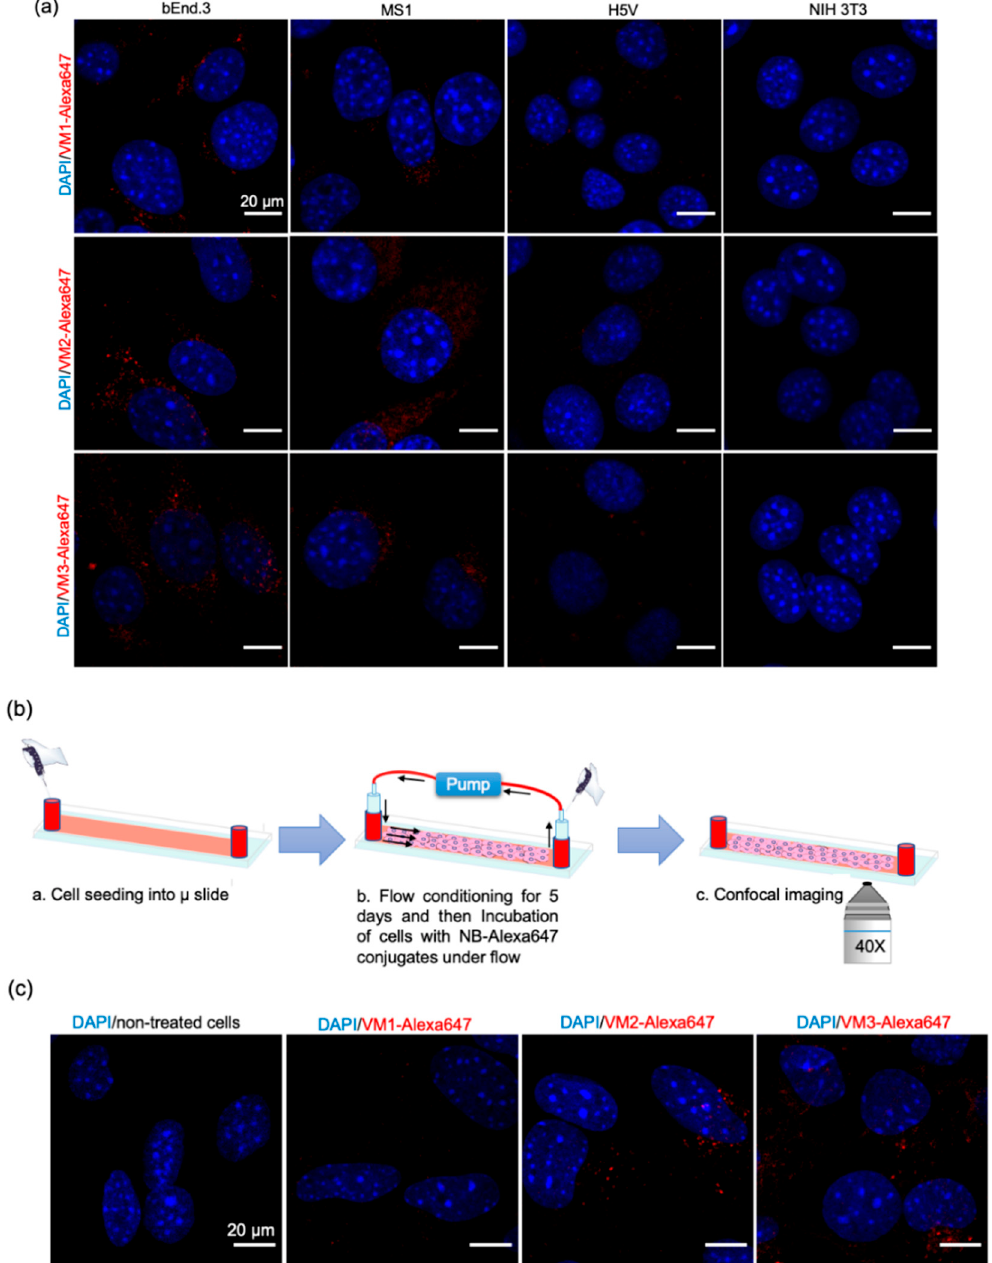
Figure 2. Association of the NB–Alexa647 conjugates with the murine cells after 1-h incubation under static and flow conditions. ( a ) Confocal images of the cells incubated with the NB–Alexa647 conjugates for 1 h at 37 ◦ C. Scale bar: 20 µ m. ( b ) Schematic representation of the experimental setup for the flow study using ibidi pump system ® . bEnd.3 cells were seeded into the µ slides on Day 1 and kept under a unidirectional flow for five days. Cells were incubated with the NB–Alexa647 conjugates for 1 h under flow, and slides were subsequently prepared for confocal imaging. ( c ) Representative images obtained with a confocal microscope after incubation of the conjugates with bEnd.3 cells under flow (shear stress 300 / s). Nuclei stained in blue and the conjugates shown in red. Scale bar: 20 µ m.